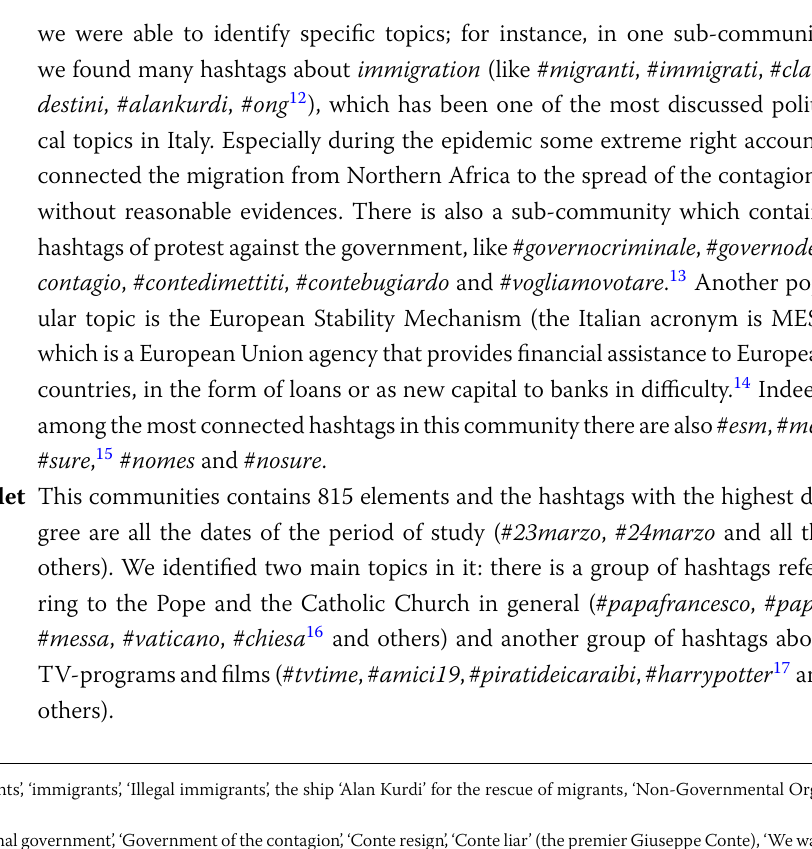
Figure 10 Thetemporalevolutionofthenumberofsocial-botsretweetingtheverifiedaccountsofthedifferent politicaldiscursivecommunities . The values on y -axis are divided, day to day, by the total number of retweets in the entire period for each community